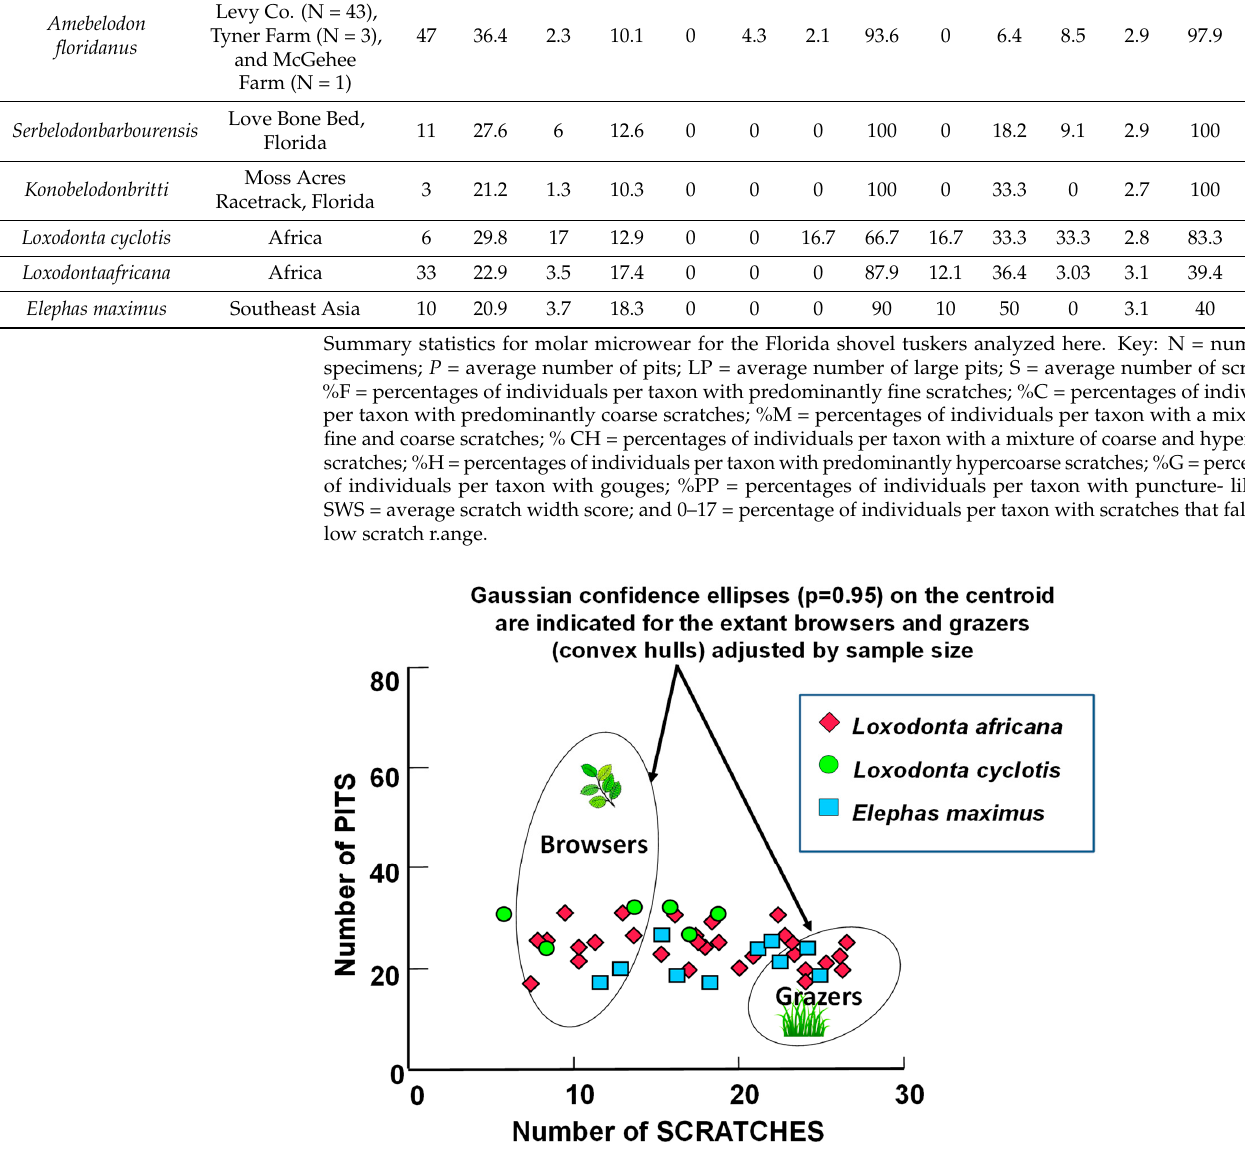
Figure 3. Raw scratch/pit results for extant elephant molars. Extant proboscidean raw scratch and pit results compared to extant ungulate scratch/pit microwear ecospaces. Extant browser and grazer ecospace data from [24]; extant proboscidean data from [34].